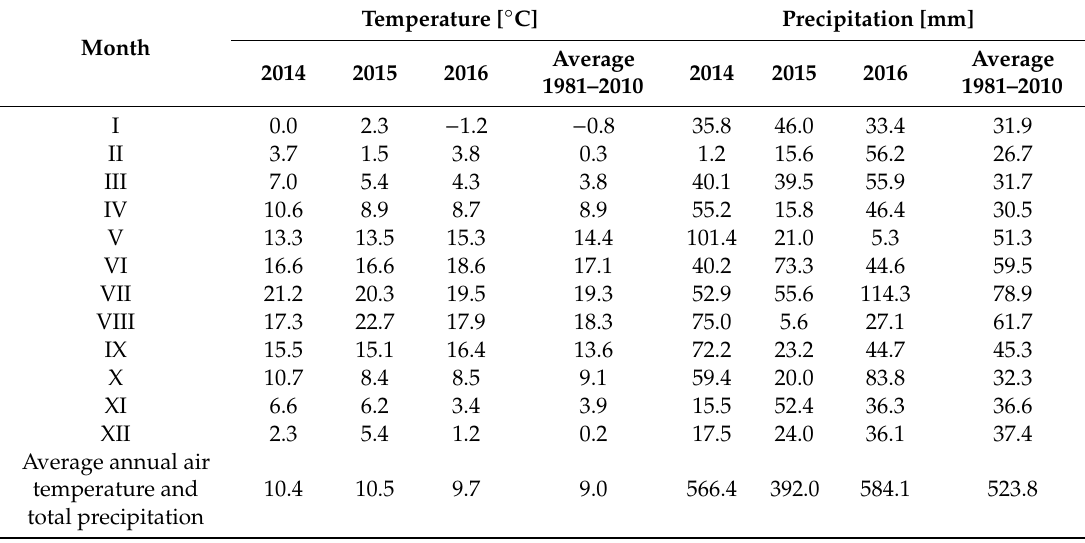
Table 3. Weather conditions during 2014–2016 with a 30-year average for Wroclaw, Lower Silesia